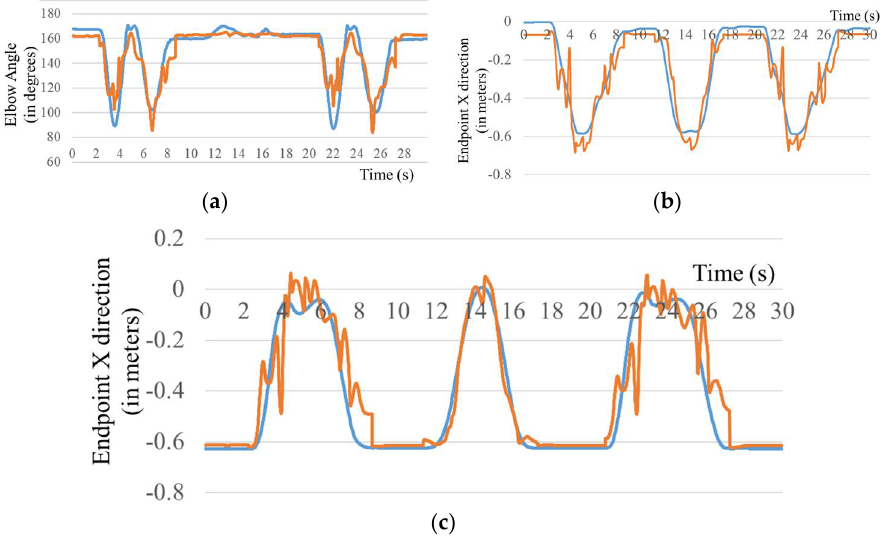
Figure 9. Comparison of data measured experimentally (blue line) and those generated by the neural network classifier (orange line). ( a ) Estimated elbow flexion/extension angle; Hand trajectory in the ( b ) x direction and ( c ) y direction.